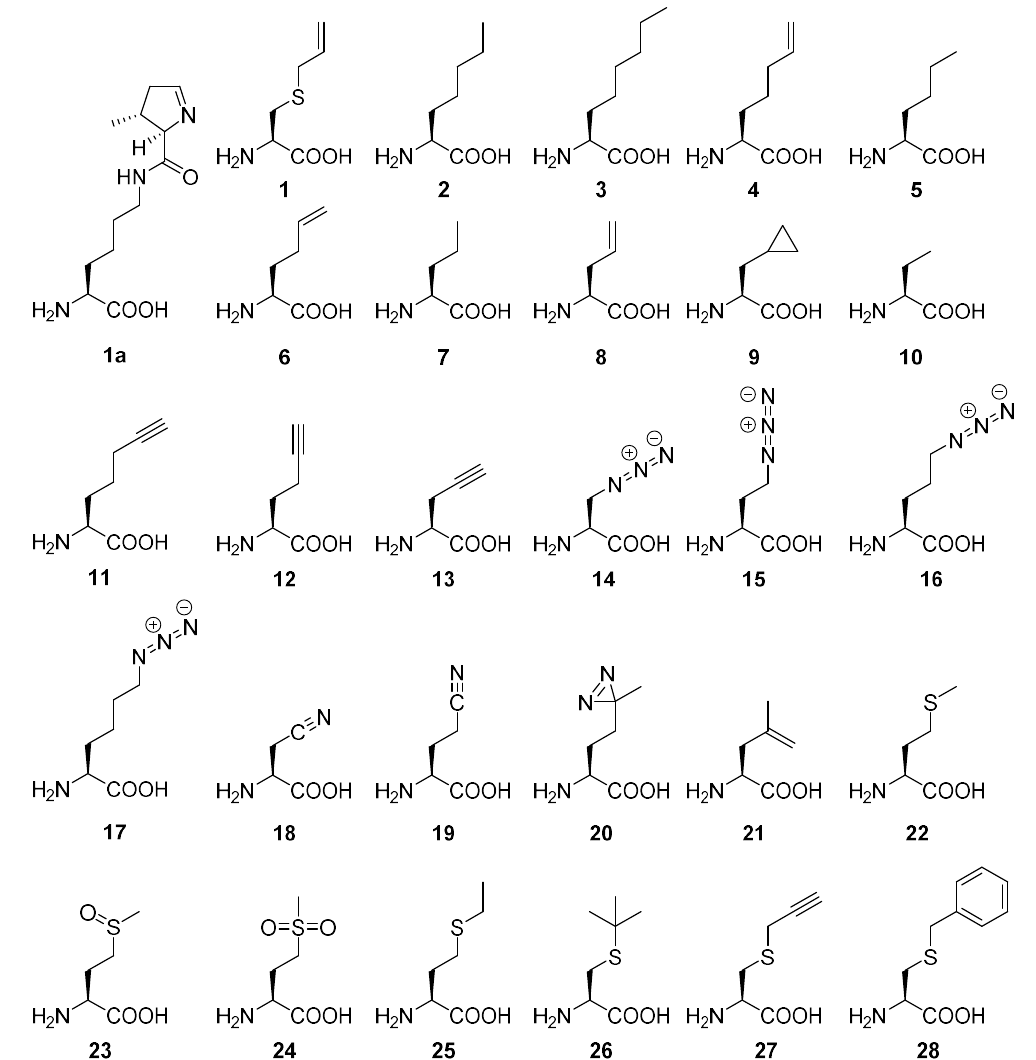
Figure 1. Survey of amino acids used in this study. Chemical structure of pyrrolysine (1a), S -allyl- L -cysteine (1), ( S )-2-aminoheptanoic acid (2), ( S )-2-aminooctanoic acid (3), ( S )-2-aminohept-6-enoic acid (4), ( S )-2-aminohexanoic acid (5), ( S )-2-aminohex-5-enoic acid (6), ( S )-2-aminopentanoic acid (7), ( S )-2-aminopent-4-enoic acid (8), ( S )-2-amino-3-cyclopropylpropanoic acid (9), ( S )-2-aminobutyric acid (10), ( S )-2-aminohept-6-ynoic acid (11), ( S )-2-aminohex-5-ynoic acid (12), ( S )-2-aminopent-4-ynoic acid (13), ( S )-2-amino-3-azidopropanoic acid (14), ( S )-2-amino-4-azidobutanoic acid (15), ( S )-2-amino-5-azidopentanoic acid (16), ( S )-2-amino-6-azidohexanoic acid (17), ( S )-2-amino-3-cyanopropanoic acid (18), ( S )-2-amino-4-cyanobutanoic acid (19), ( S )-2-amino-5,5’-azi-hexanoic acid (20), ( S )-2-amino-4-methylpent-4-enoic acid (21), L -methionine (22), L -methionine sulfoxide (23), L -methionine sulfone (24), L -ethionine (25), S -tert-butyl- L -cysteine (26), S -propargyl- L -cysteine (27), S -benzyl- L -cysteine (28).